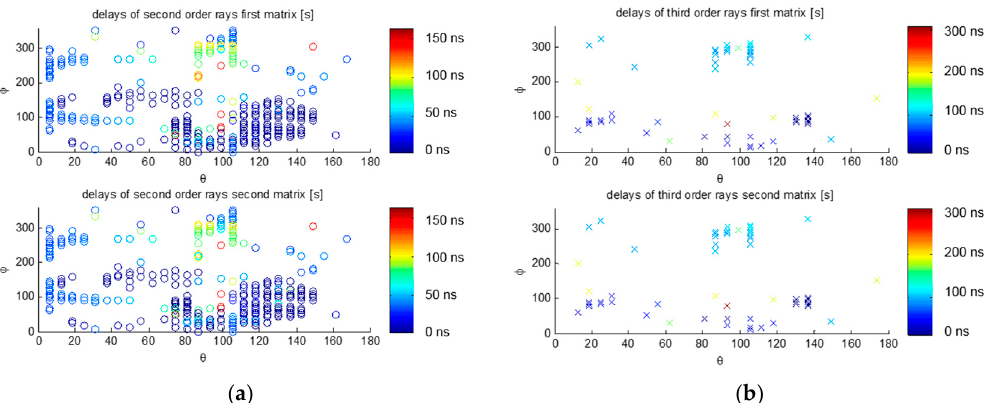
Figure 10. ( a ) Delays for the second order rays, and ( b ) for the third order rays. Direction of Arrival ( θ , φ ) in the antenna far field. Co-polar antenna pattern used for the direct and third order rays, cross-polar pattern used for the second order rays. Top: first matrix and bottom: second matrix, refer to the fact that there are second order and third order rays that have the same far field direction, but enter through different directions in the antenna pattern reference frame. Color code corresponds to the delay in ns.